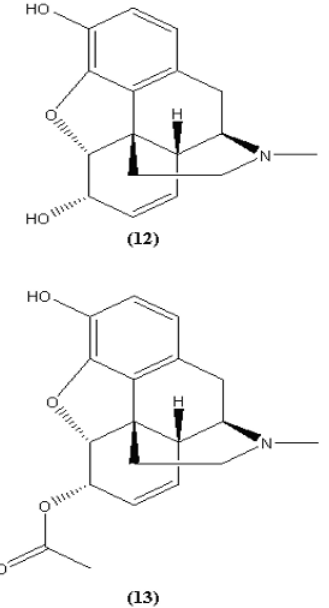
Figure 5. The structures of morphine ( 12 ) and 6–acetylmorphine (6AM, 13